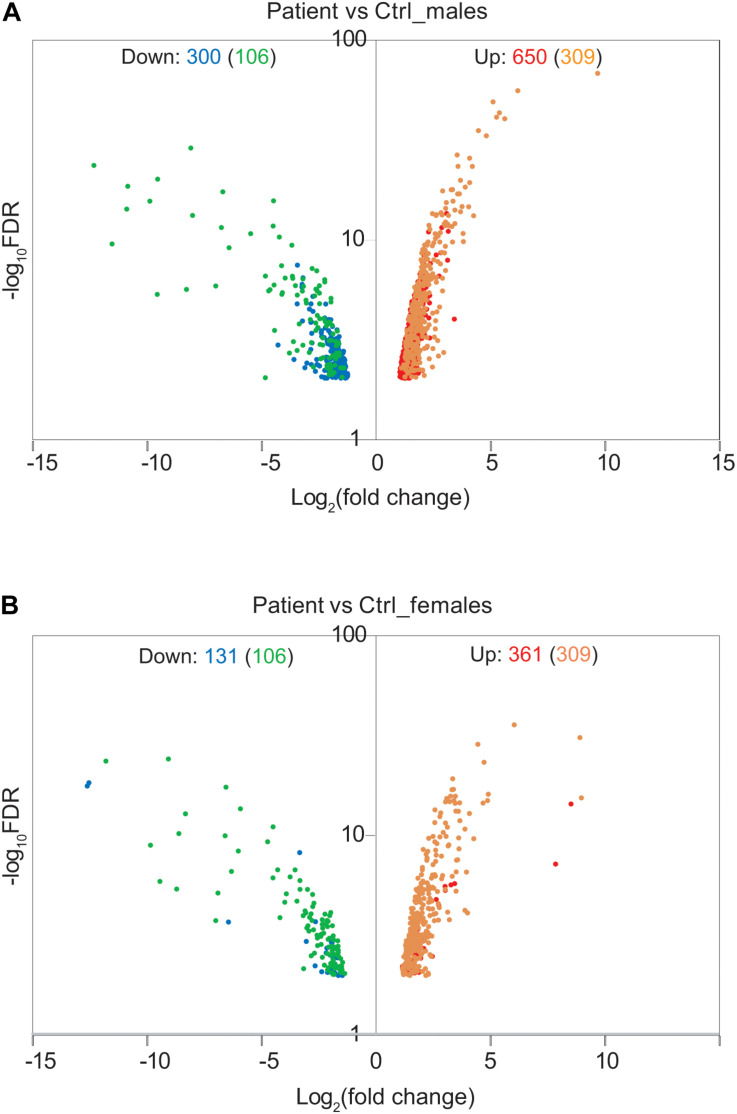
Effect of Xq28 deletion on global gene expression in the patient. (A) Volcano diagram of differentially expressed genes (DEGs) in the patient versus control (Ctrl) males. Horizontal axis represents expression fold change changes (log2) and vertical axis represents FDR (log10). DEGs with | log2 fold change| > 1 and FDR < 0.01 were plotted. Down- or up-regulated DEGs are shown in blue or red, respectively. Overlapped DEGs that were significantly down- or up-regulated both in the patient versus control males and in the patient versus control females are also indicated by green or yellow, respectively. The number of these overlapped DEGs is present in the parenthesis. (B) Volcano diagram of DEGs in the patient versus control females. The same analysis is done as in (A).